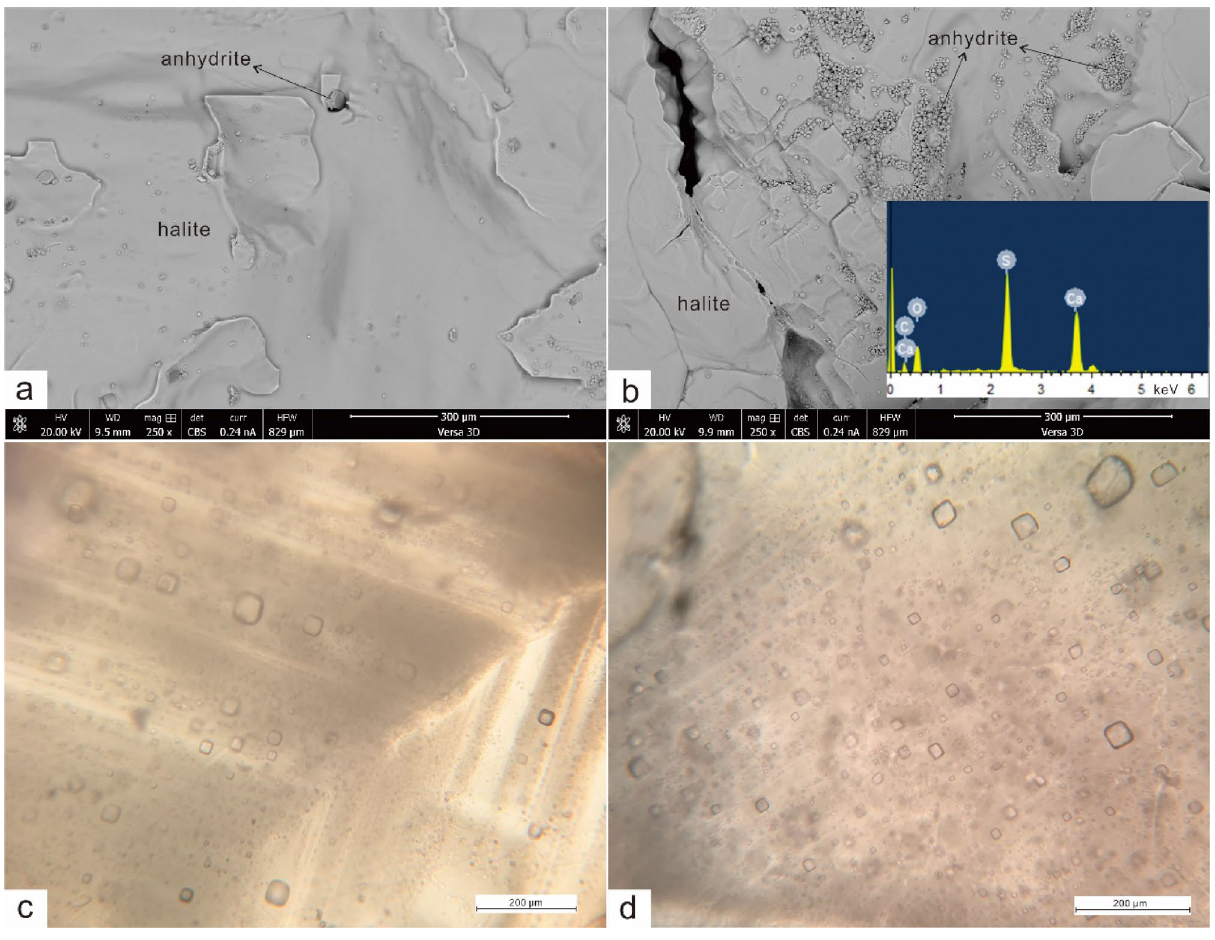
Figure 3. SEM images of evaporite samples and characteristics of fluid inclusions in halite ( a ) pure halite; ( b ) halite with trace amount of anhydrite (inset shows EDS analysis of fine-grained anhydrite); ( c ) chevron halite crystal; ( d ) hopper halite